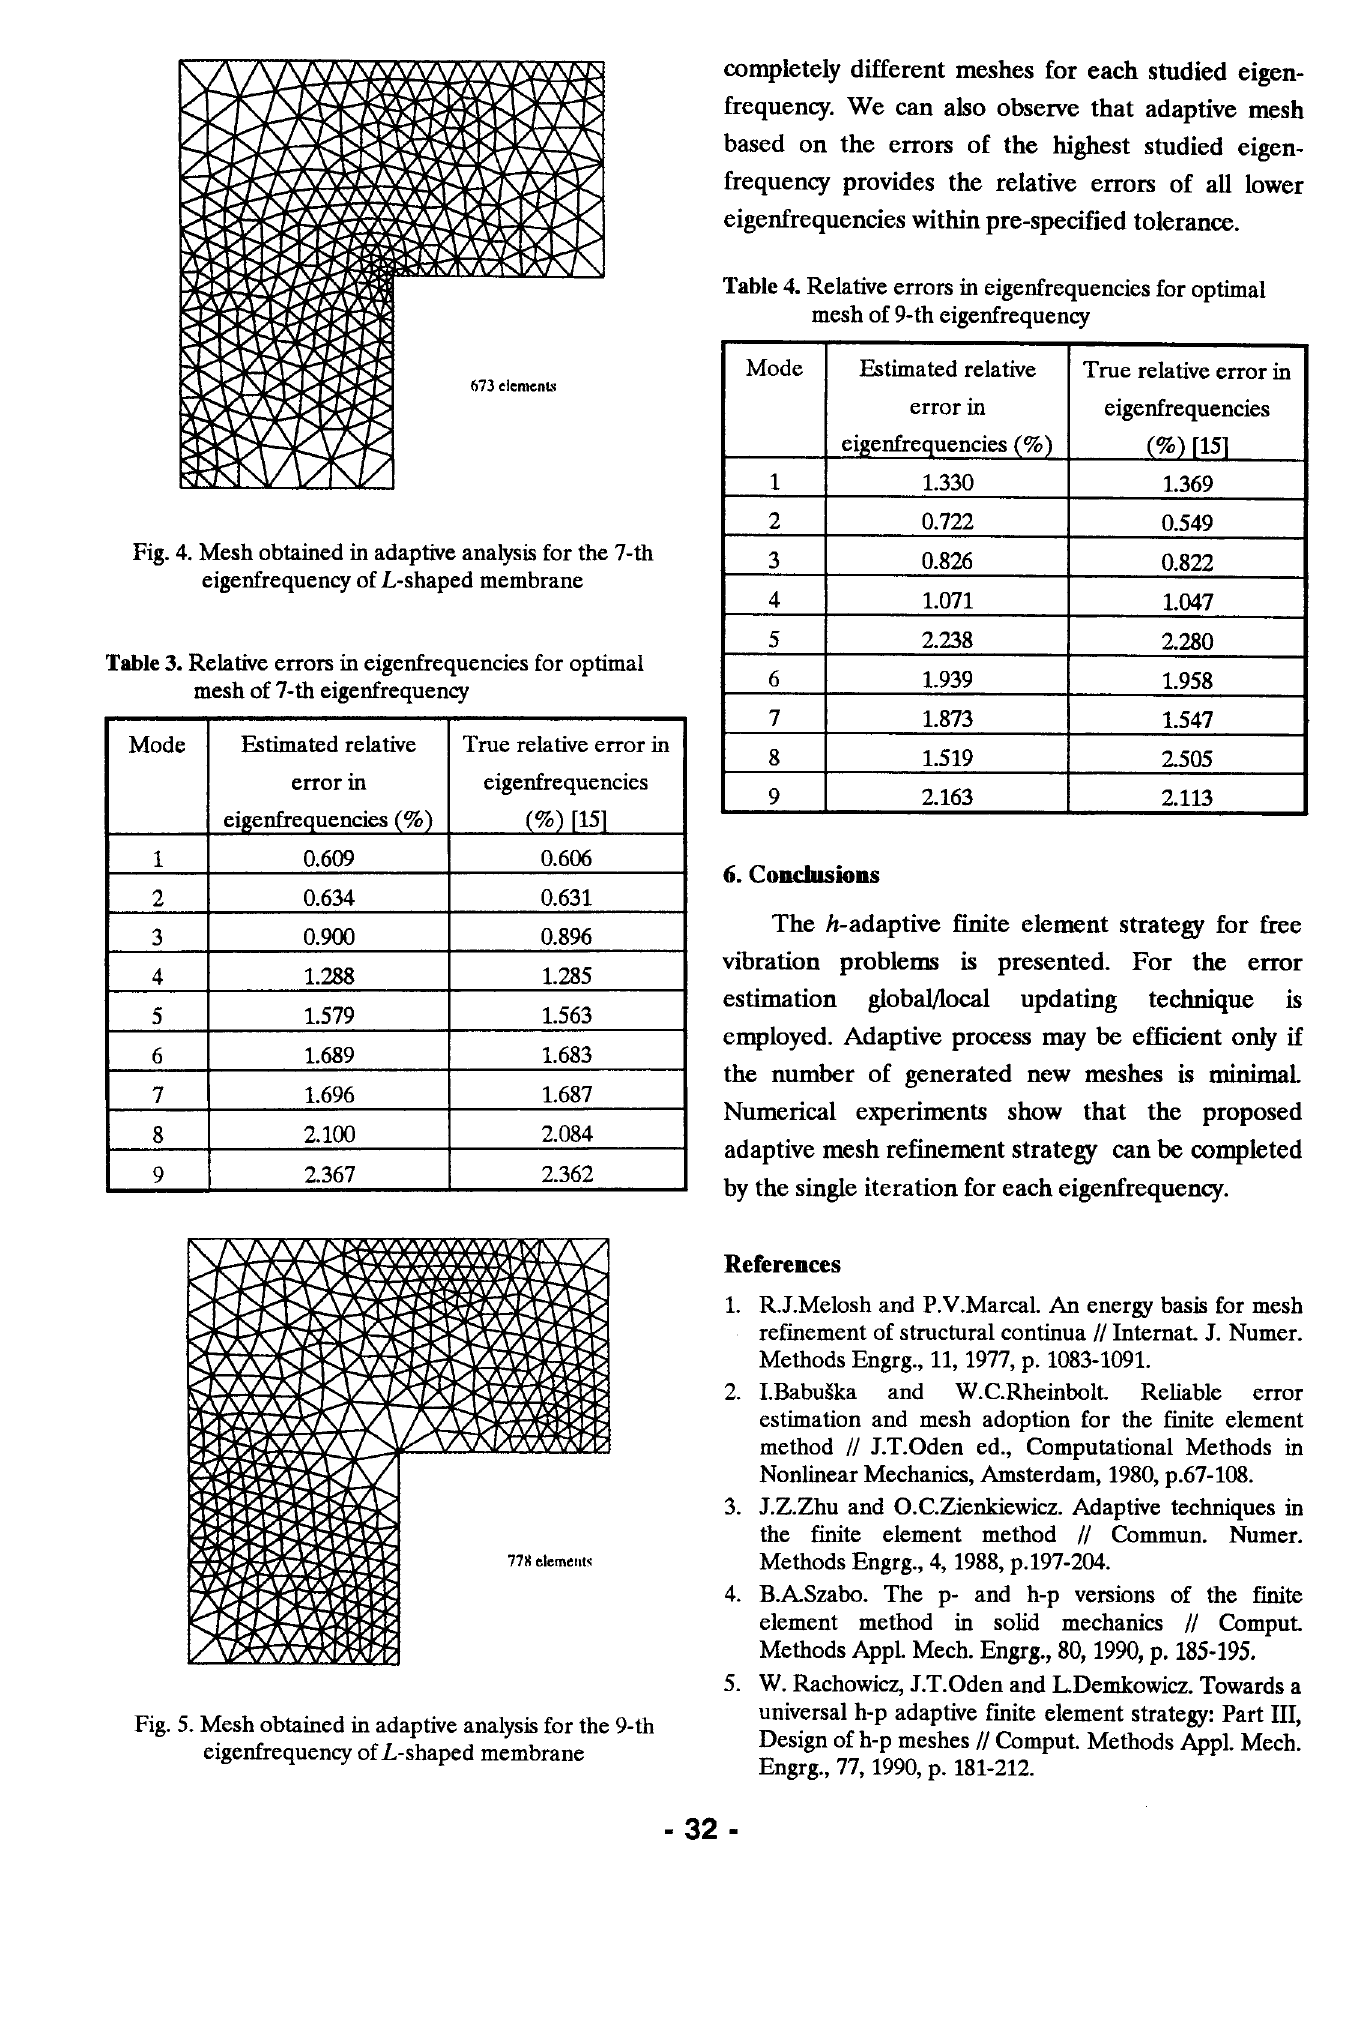
Table 4. Relative errors in eigenfrequencies for optimal mesh of 9-th eigenfrequency Mode Btimated